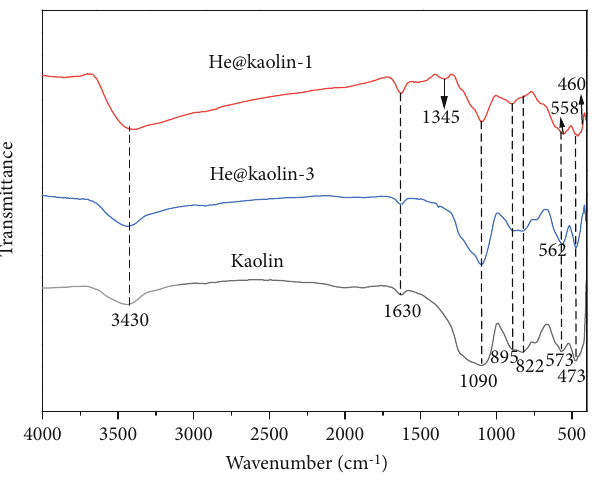
Figure 3: FTIR spectra of kaolin, He@kaolin-3, and